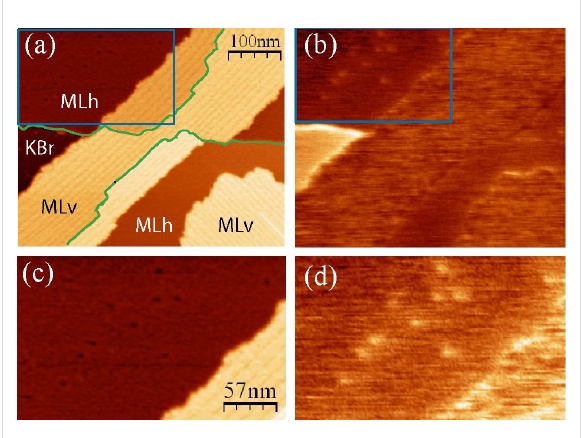
Figure 7: High resolution topographic images of an MLh domain. A = 2 nm. (a) Δ f = − 35 Hz, (b) Δ f = − 50 Hz. The unit cell is indicated in